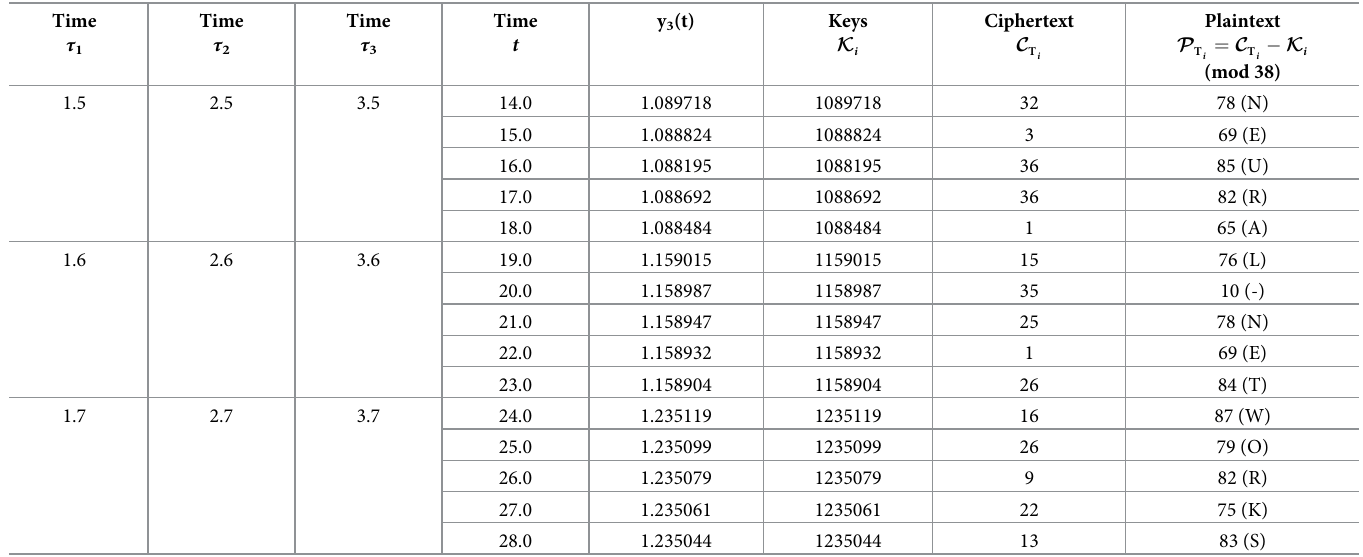
Table 7. Decryption of ciphertext to